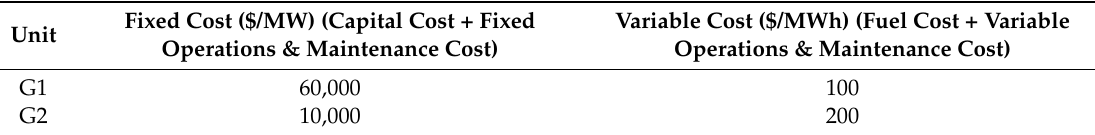
Table 1. Cost data for two generator units.